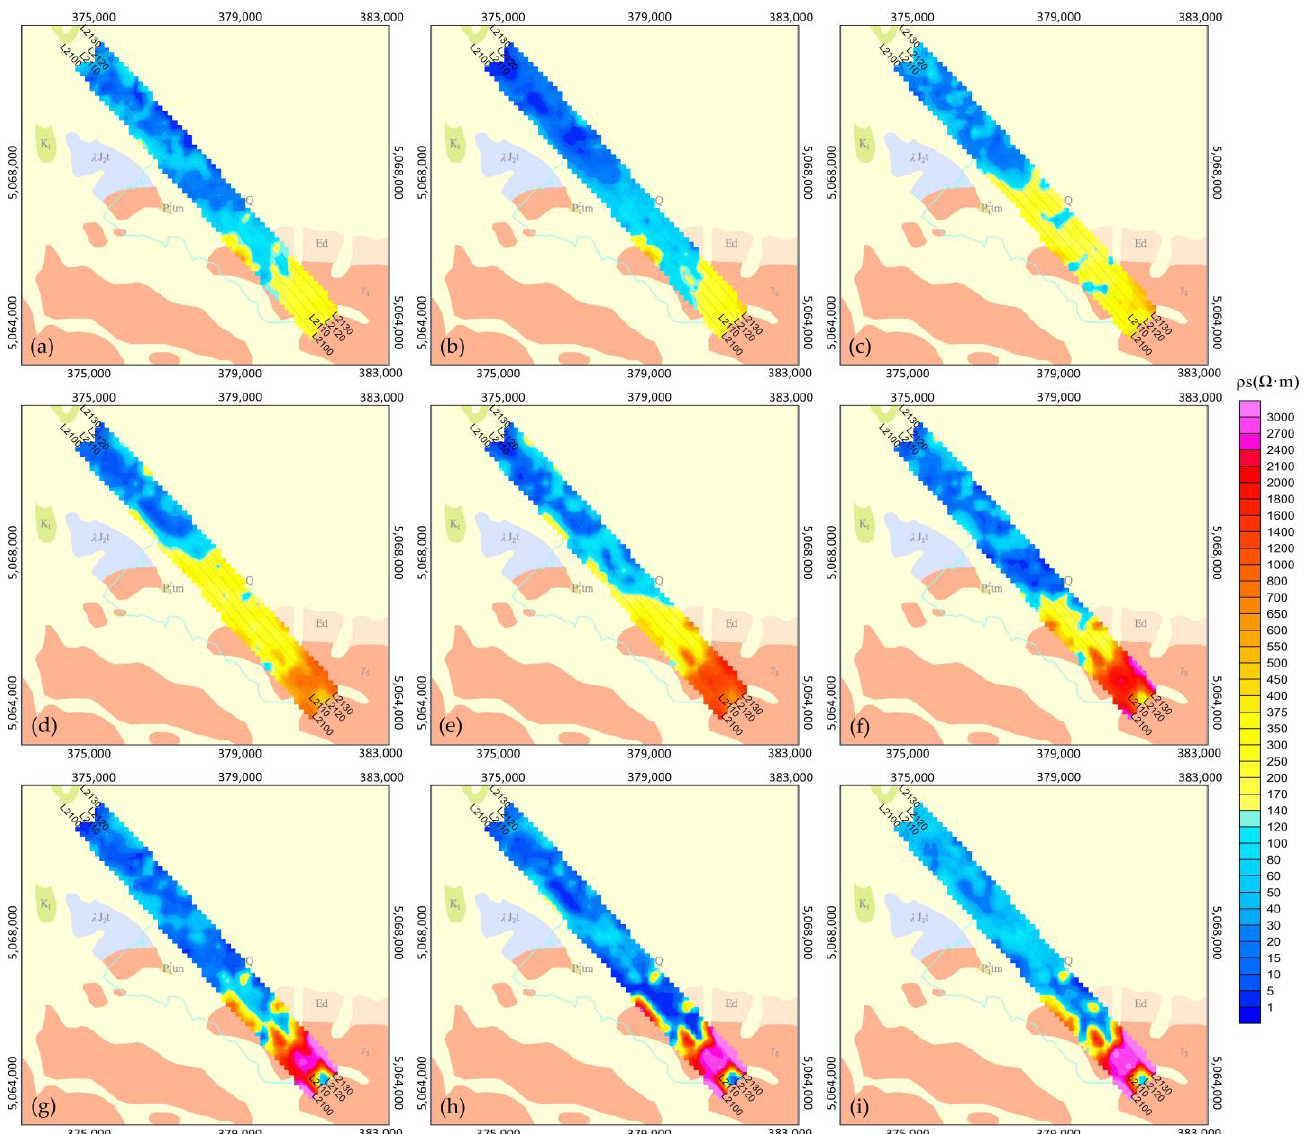
Figure 9. Resistivity plane contour map at different depths: ( a ) −2 0 m; ( b ) −6 0 m; ( c ) −1 00 m; ( d ) −1 50 m; ( e ) −2 00 m; ( f ) −2 50 m; ( g ) −3 00 m; ( h ) −3 50 m; ( i ) −4 00 m.